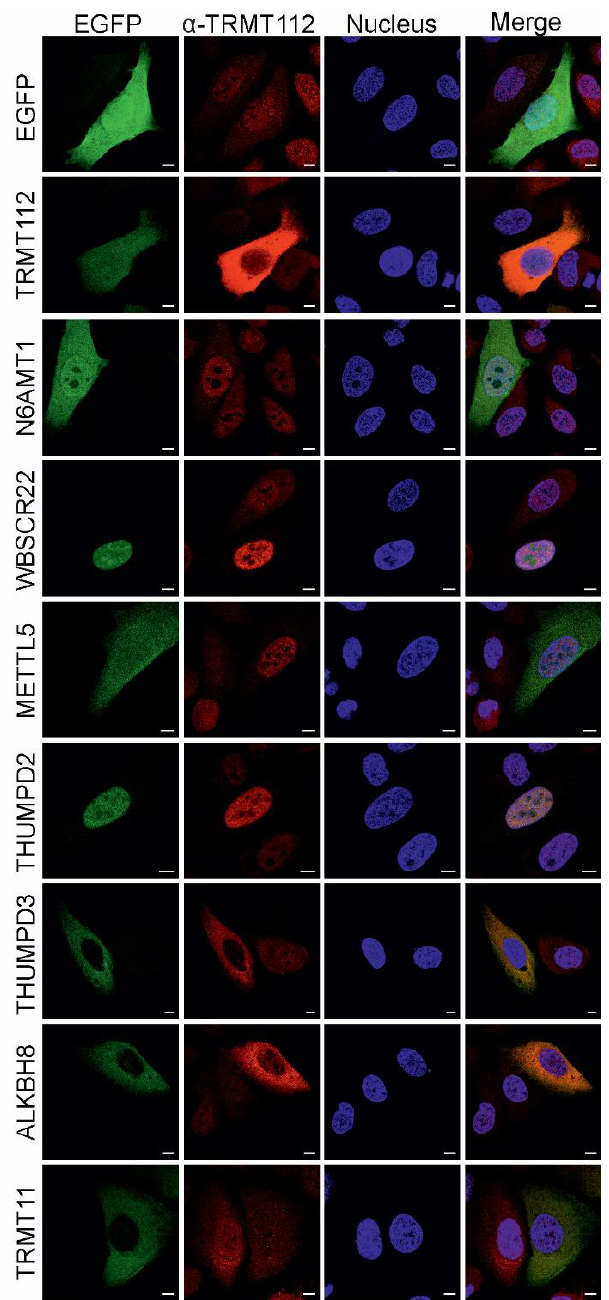
Figure 2. Subcellular localisation of TRMT112 and its partner MTases in U2OS cells. EGFP-fused MTases were expressed in U2OS cells, and their localization, together with endogenous TRMT112 protein, was analysed. The signal of EGFP was revealed through its own fluorescence and TRMT112 with specific monoclonal antibodies to TRMT112, and secondary antibody conjugated with Alexa-568. Cells were counterstained with DAPI for DNA labelling. Image sections were captured with Zeiss LSM710 confocal microscope at 63x magnification. Scale bar 10 µm.